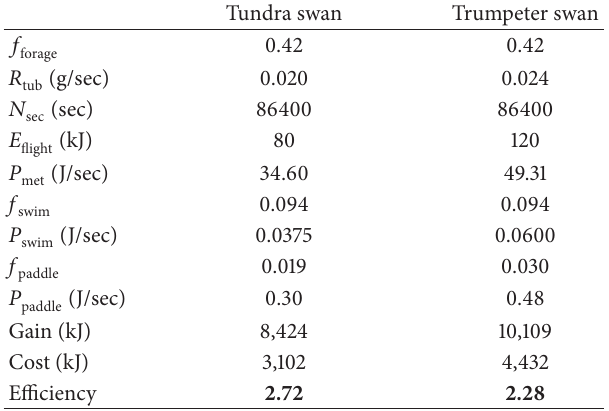
Table 4: Calculation of efficiency indices for tundra and trumpeter swans. The index is defined as the ratio between foraging gains and total energy requirements in one day, including costs of free living and mechanical costs of foraging flights, swimming, and paddling. ) was derived from Nolet et al. [49] Intake rate for tundra swans ( 𝑅 tub ), for clayey substrate. Fraction of each day spent foraging ( 𝑓 forage ), and paddling ( 𝑓 ) is based on observations swimming ( 𝑓 swim paddle for of foraging swans. Powell and Engelhardt [56] reported 𝐸 flight a 5 kilometer foraging flight. Mechanical costs are not adjusted by aerobic